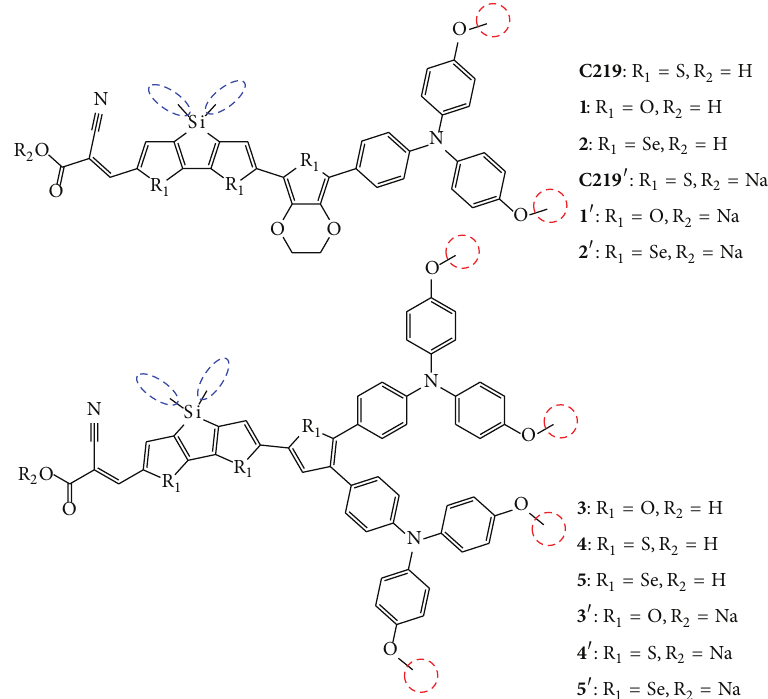
Figure 1: Schematic structures of the tpa-based sensitizers. The C 6 H 13+ and C 8 H 17+ groups in the tpa-based sensitizers are replaced by methyl groups marked with blue dash-lined ellipses and red dash-lined